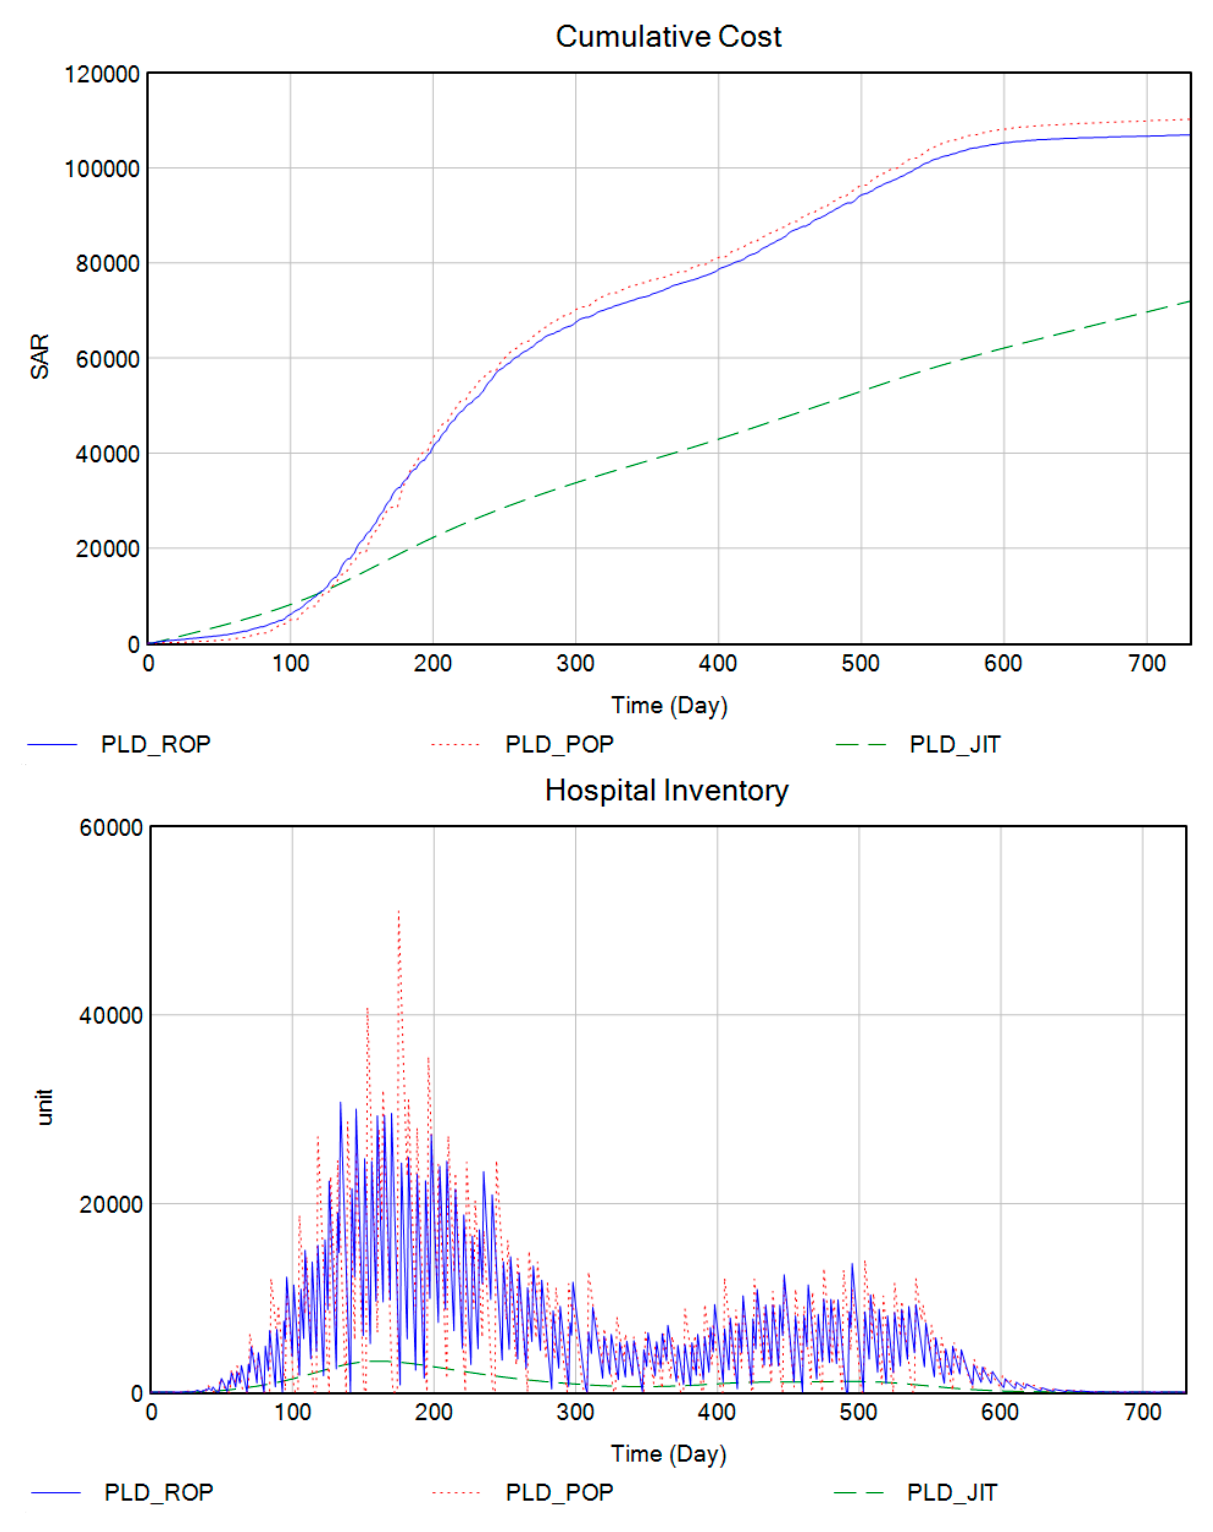
Figure 5. Comparison of inventory policies during PLD.